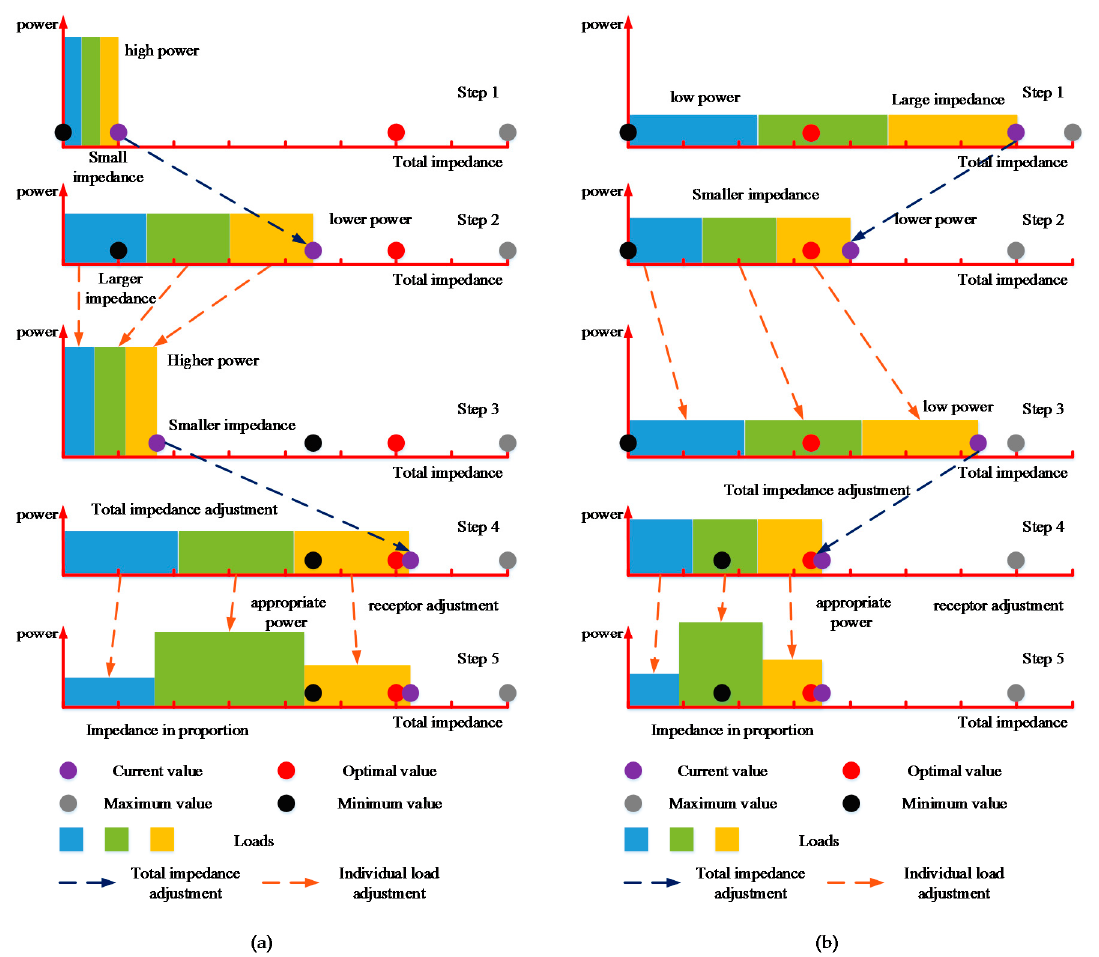
Figure 5. Load adjustment process. ( a ) power surplus case, ( b ) power deficiency case.